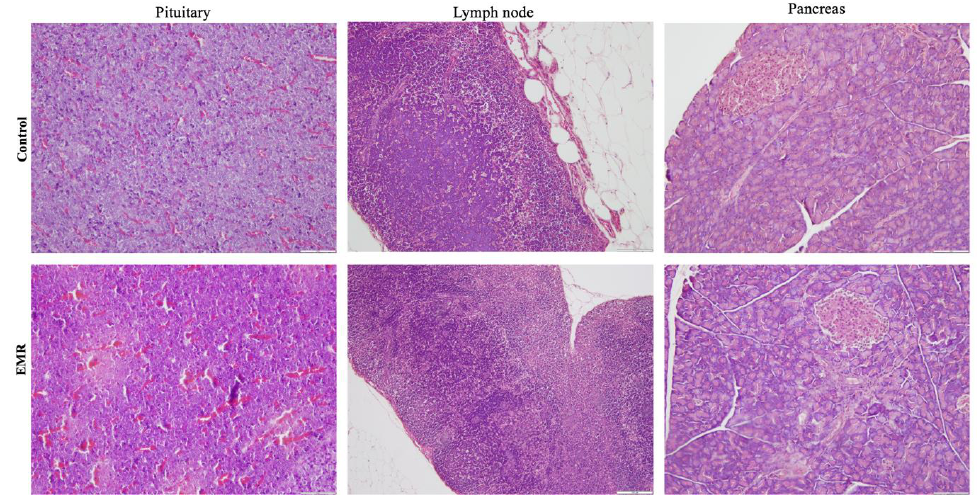
Figure 6. The effect of 150 kHz IF EMR on the histopathology of the pituitary, lymph node, and pancreas of rats in the control and EMR groups after 2 months of whole-body exposure. In the pituitary gland, small groups of normal-looking secretory cells were visible between thin-walled blood vessels. The lymph nodes showed typical lymphoid follicles and parafollicular tissue and were structurally normal. The pancreas showed typical pancreatic islets, ducts, and acini. (H&E × 200).